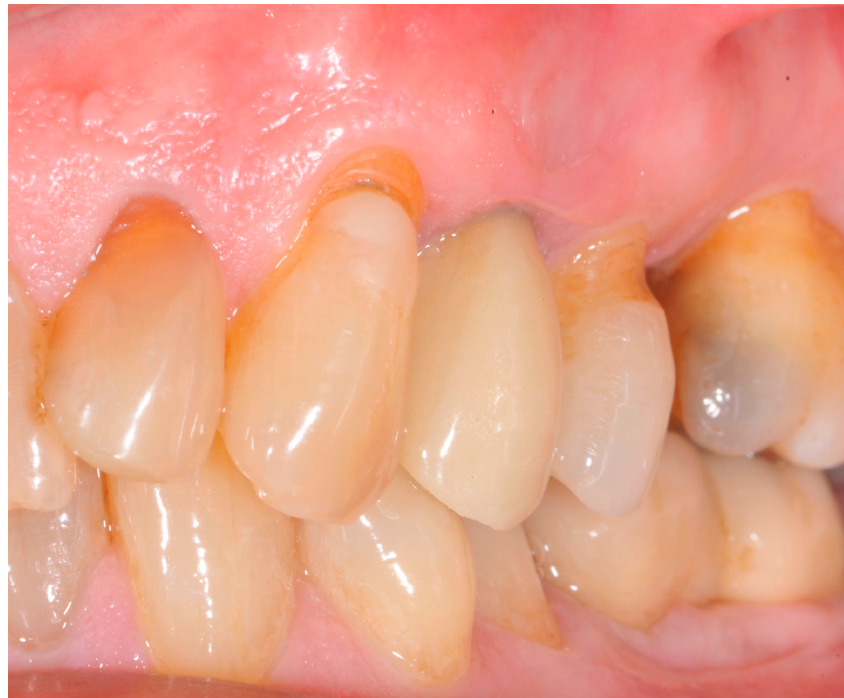
Figure 10. Clinical situation at delivery of the definitive screw-retained restoration .